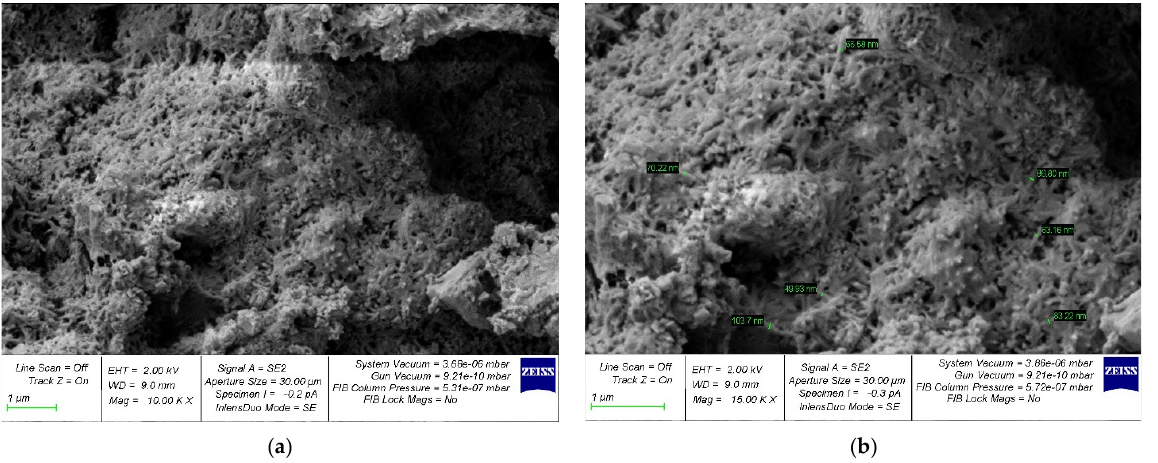
Figure 8. Samples with a nanosilica content of 5% by weight of cement with an increase: ( a ) 10,000× and ( b ) 15,000×.